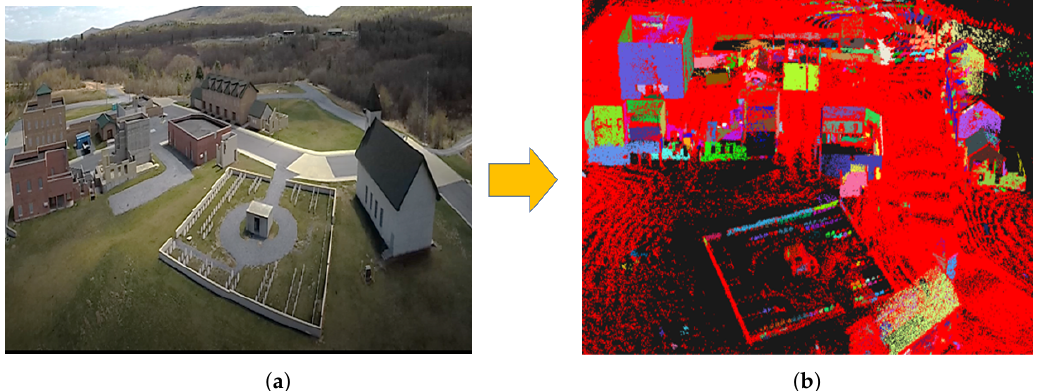
Figure 4. ( a ) Visual image of FTIG from view angle of unmanned aircraft. ( b ) Created point cloud of FTIG with over 1000 detected planar features. Each planar feature is highlighted with a different color. The 4.4 million element point cloud was processed using a C++ implementation of the RANSAC algorithm in under 8